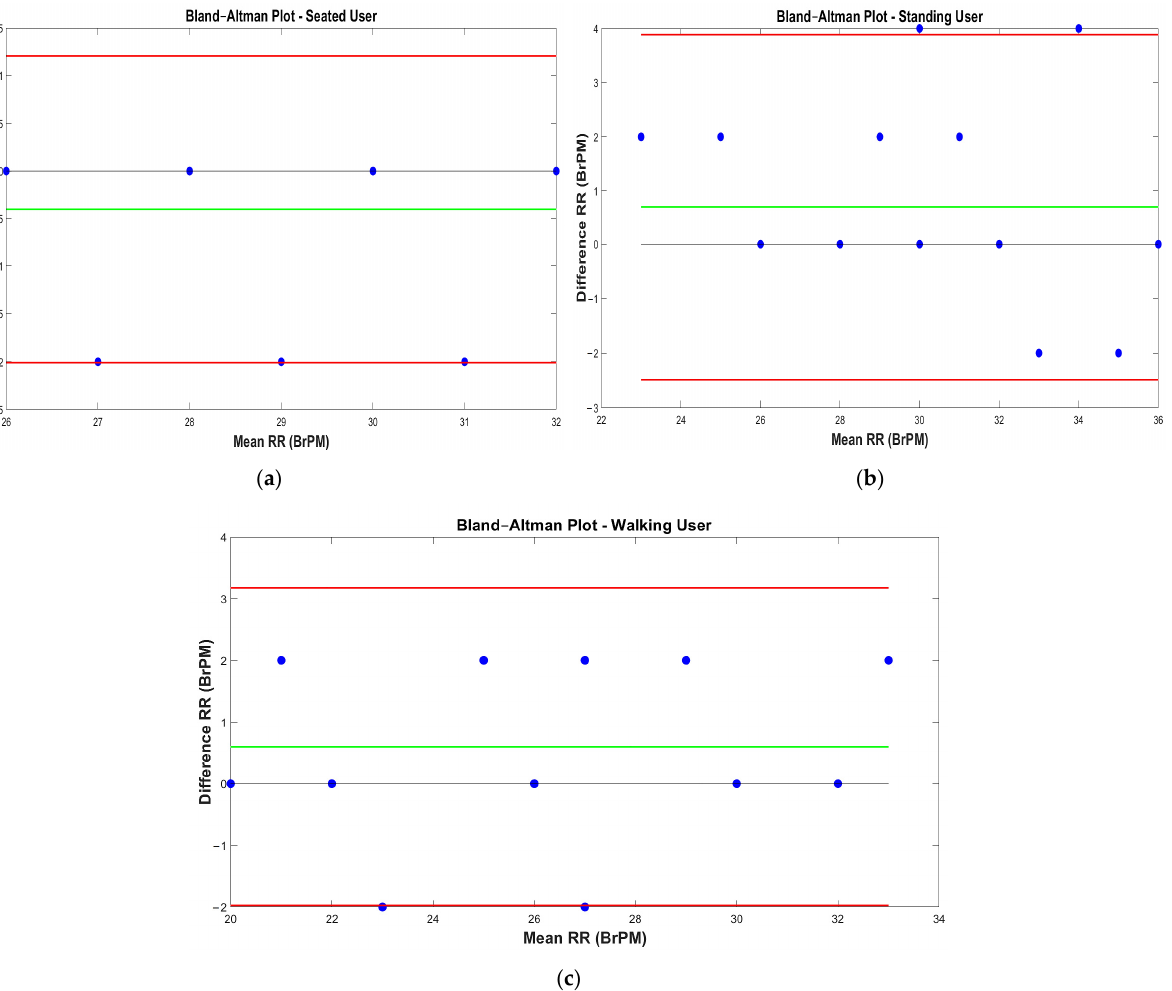
Figure 11. Bland–Altman plots of the RR measurements obtained using the developed chest band and the reference ones for different operating conditions: seated user ( a ), standing user ( b ), and a 1 ms − 1 walking user ( c ); the blue dots represent the data points, whereas the green and red lines the MD and LoA values, respectively.